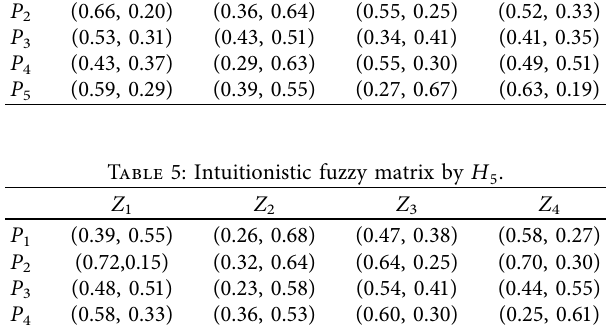
Table 4: Intuitionistic fuzzy matrix by H